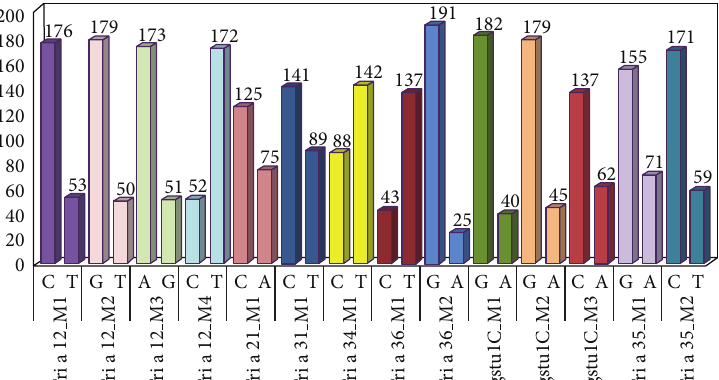
Figure 3: Histogram of allelic variant identified for each of analyzed allergen. The numbers on the bottom indicates the number of genotypes of the collection carrying each